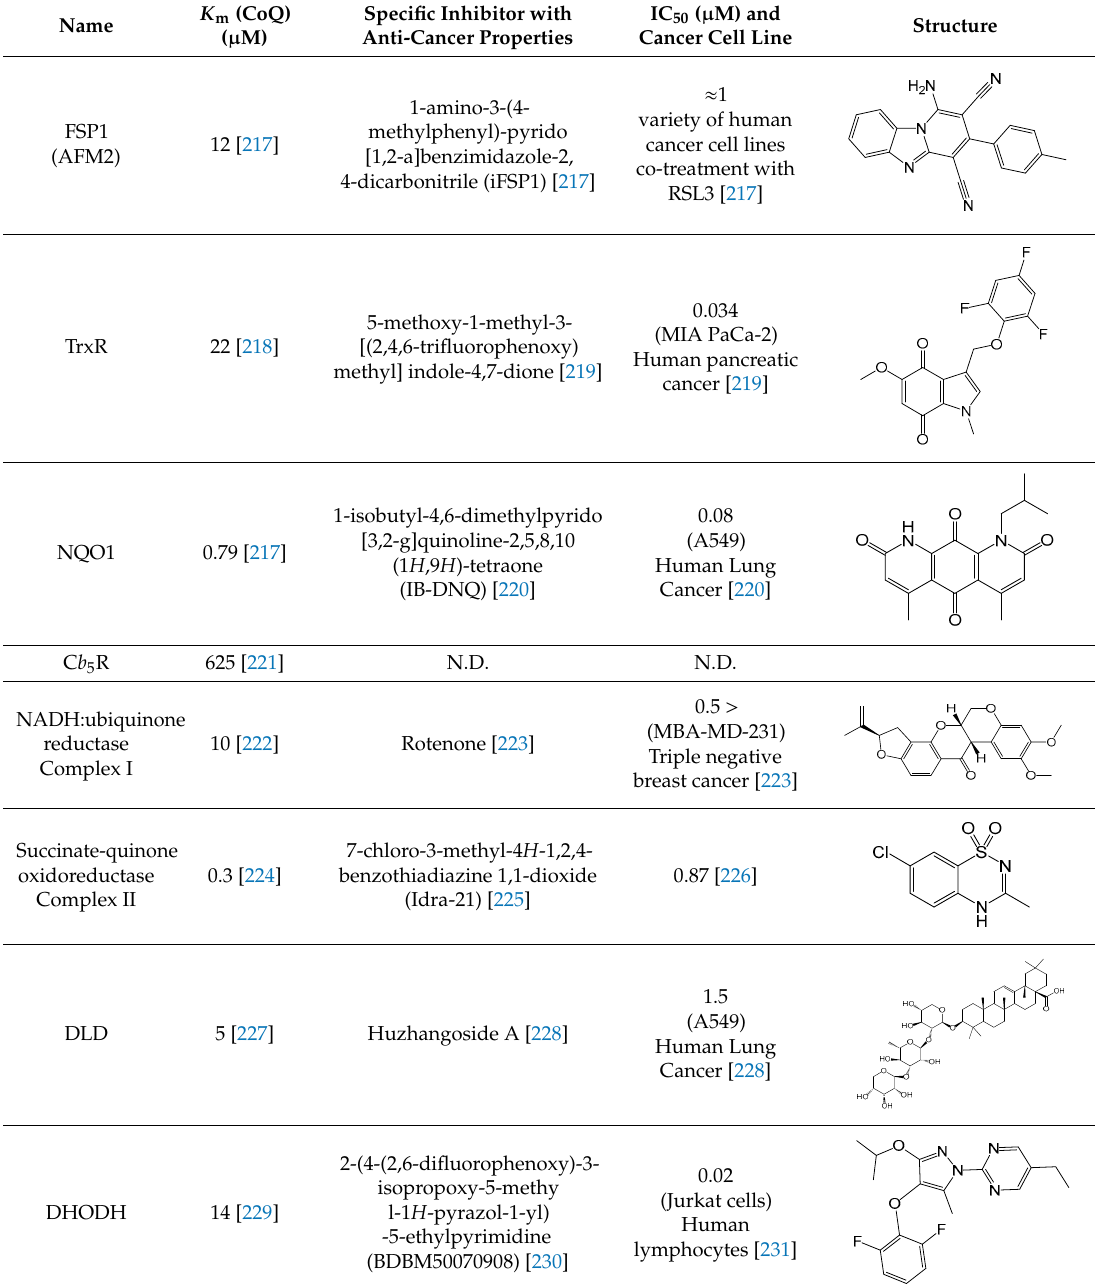
Table 3. Summary of enzymes with Quinone Reductases (QR) activity, reported kinetic properties, and implication in cancer.